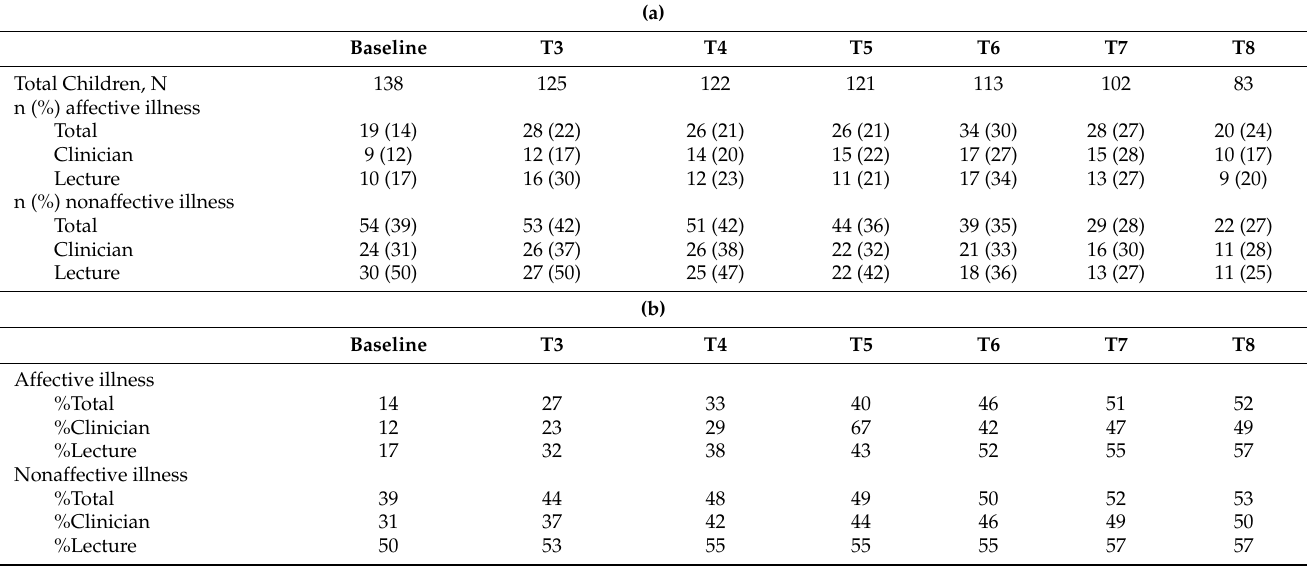
Table 4. ( a ). Child-level illness; ( b ). Child cumulative lifetime illness (N =